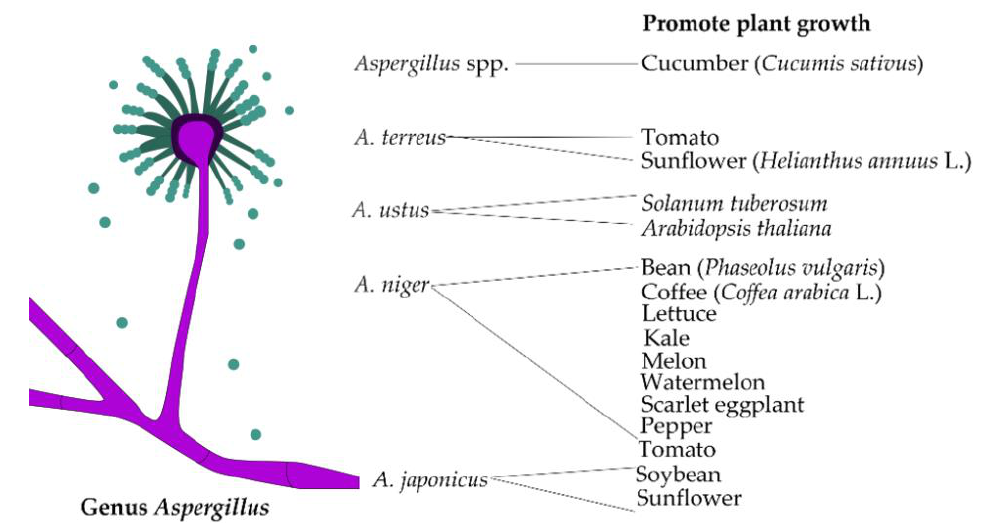
Figure 3. Species of the genus Aspergillus used in the promotion of plant growth.